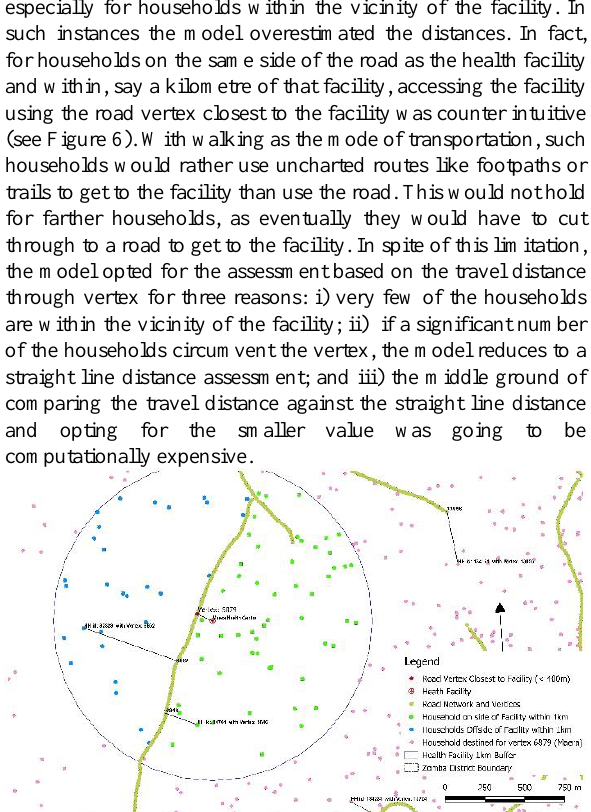
Figure 7 Health care accessibility for households in Zomba.